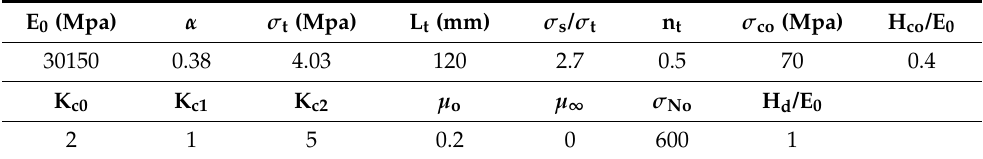
Table 10. LDPM mechanical parameters.